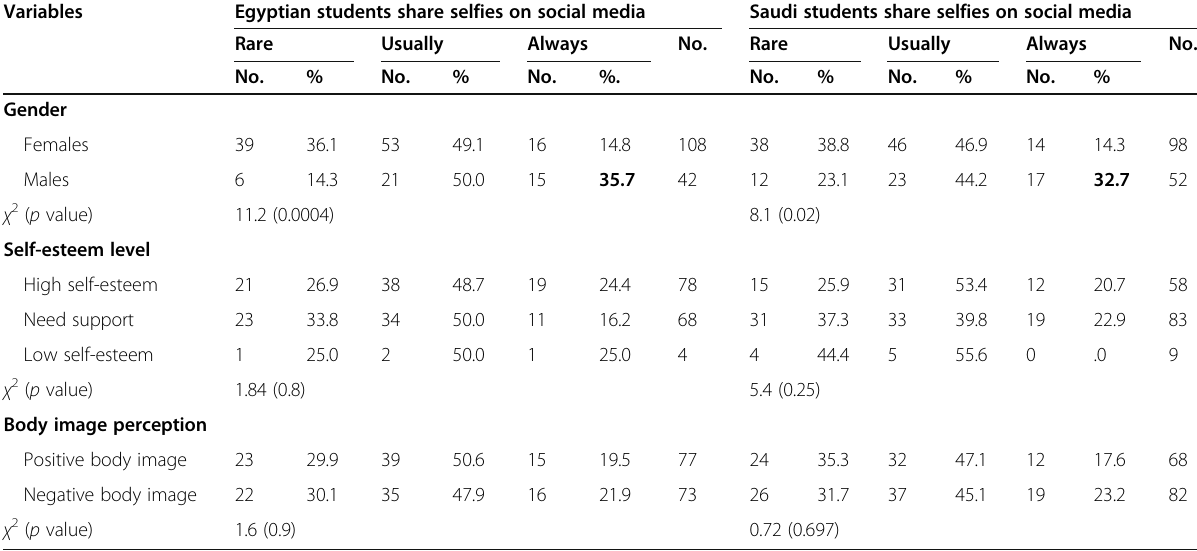
Table 7 Relationship between share selfies on social media among Egyptian and Saudi nursing students and their gender, self- esteem, and body image perception